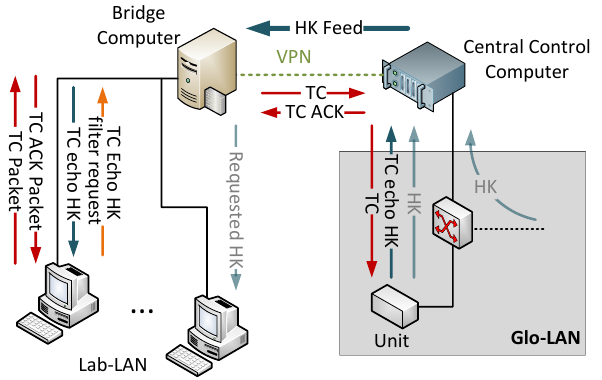
Figure 7. Telecommand (TC) and housekeeping (HK) relaying be- tween the operators and the GLORIA housekeeping and control units. The relaying takes place over the cascaded Spider application running on the central control computer and on the bridge com- puter. The TC acknowledge (ACK) is sent back from the Spider on the central control computer to the originating operator’s shell upon delivery of the TC packet to the unit, which also sends an echo con- firmation in the form of an HK data packet. Just as with any other HK data packet, the TC echo packet must be requested by the oper- ator and sent via the HK feed from the central control computer in order to be